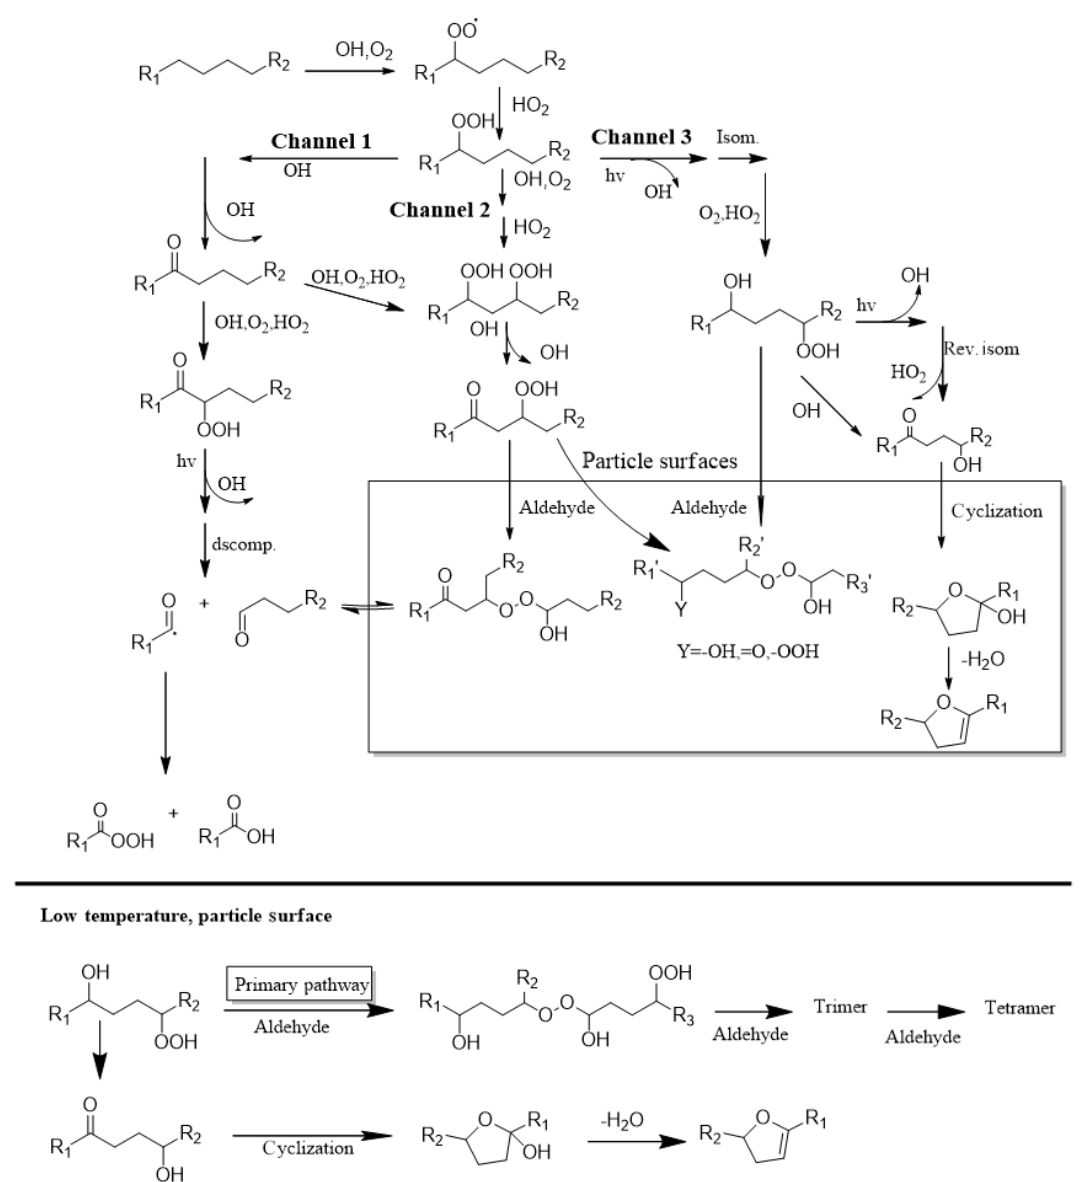
Figure 4. The proposed reaction mechanism of long-chain alkanes under low-NO x conditions (Fahnestock et al., 2015; Yee et al., 2013,